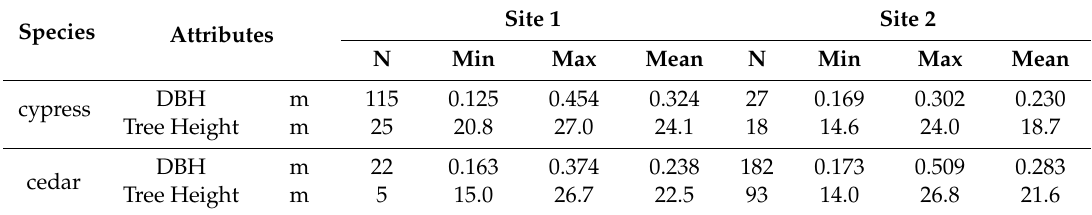
Table 3. Summary of Field